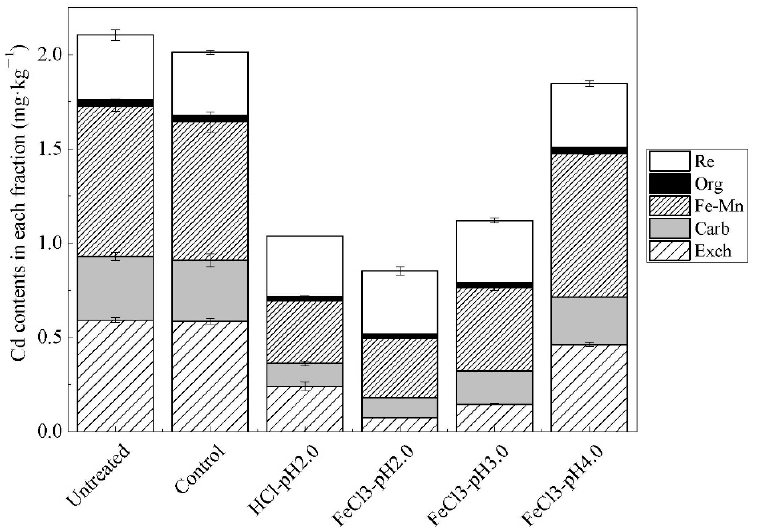
Figure 2. Sequential extraction of Cd from contaminated paddy soil with FeCl 3 . Note: Exch, Carb, Fe–Mn, Org, and Re refer to exchangeable Cd, Cd bound to carbonates, Cd bound to iron and manganese oxides, Cd bound to organic matter, and residual Cd. Table 1. TOC, DOC, and Fe(II) concentrations in different treatments.